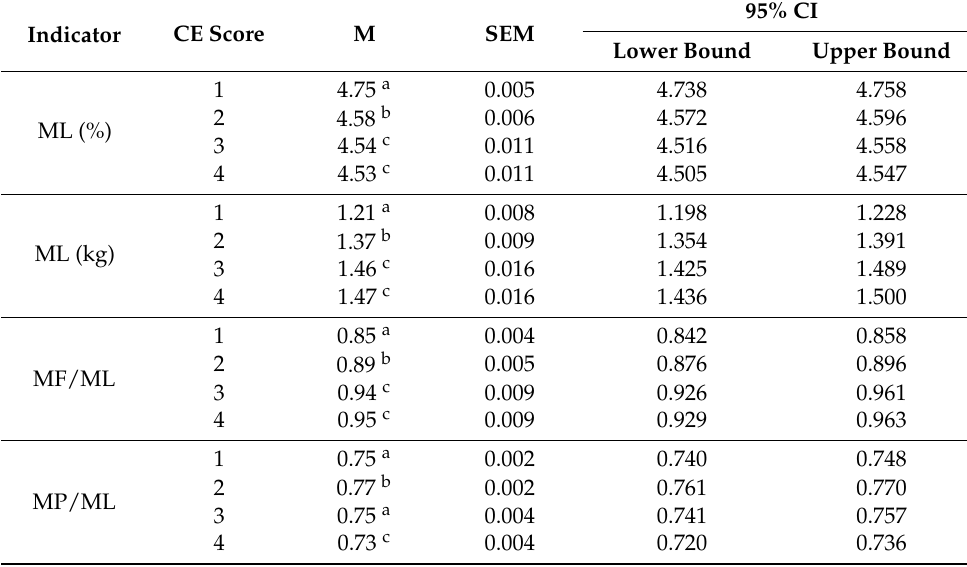
Table 1. Milk lactose and other milk components by calving ease of